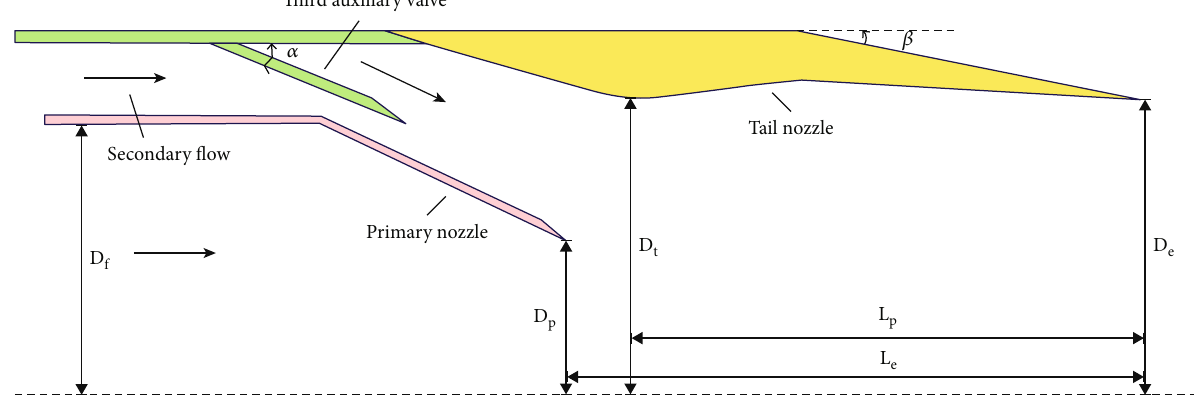
Figure 2: Two-dimensional physical structure parameters of an ejector nozzle. Table 1: Physical structure size parameters of an ejector nozzle.